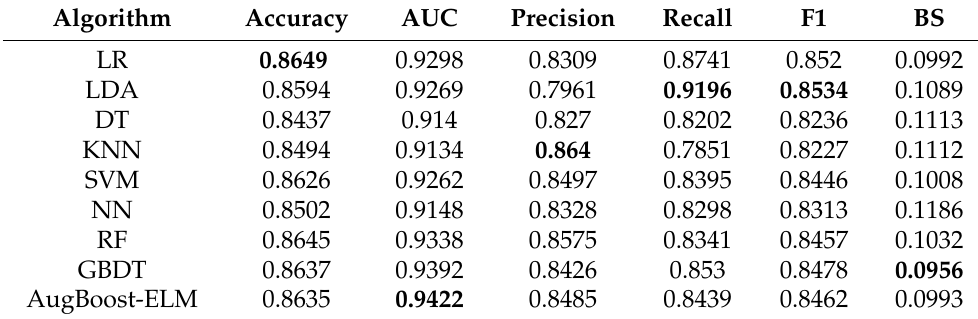
Table 4. Performance comparison of credit scoring models for the Australian dataset.